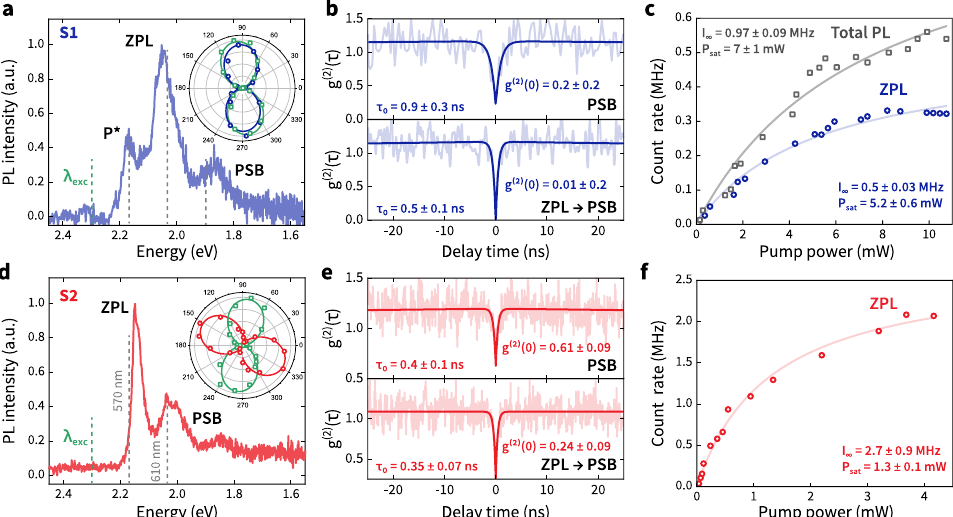
Figure 3. The µ -PL spectra of the emitters S1 ( a ) and S2 ( d ) under 532-nm excitation; the inset: PL intensity as a function of linear 532-nm excitation polarization angle (green hollow squares) or filtered by linear polarization angle in emission (blue and red hollow circles) for S1 and S2 emitters. Solid curves are fits to the data using the model discussed in the text. The photon autocorrelation of PSB (top) and cross-correlations between ZPL and PSB (bottom) for the emitters S1 ( b ) and S2 ( e ). The centers of the spectral regions of interest are indicated in ( a , d ) by dashed lines and have a bandwidth of 20 nm for the ZPL and PSB. Saturation curves for the S1 ( c ) and S2 ( f ) emitters; solid curves are fits to the data using an empirical model discussed in the